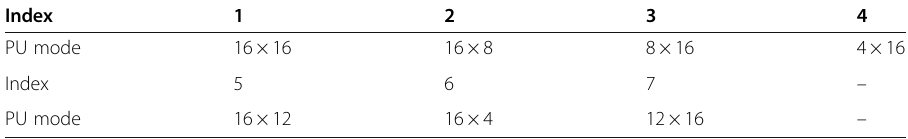
Table 2 PU partition mode for 16 × 16